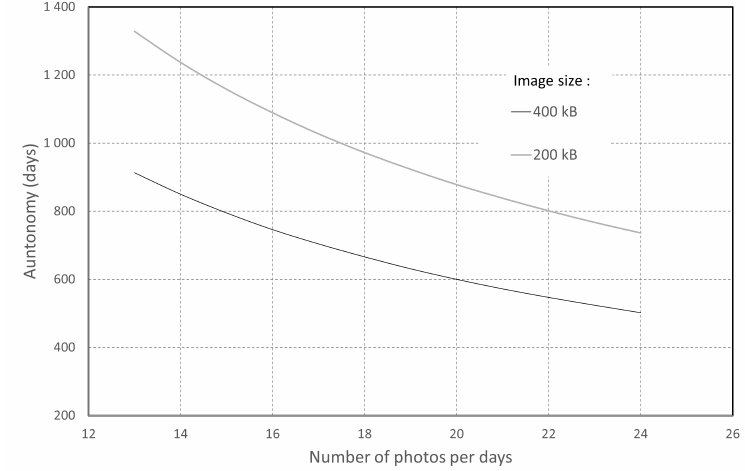
Figure 11. Estimation of the autonomy according to the number of pictures taken for 2 different image sizes (200 and 400 kB). Table 8. Raspberry Pi (RPi) Energy consumption.